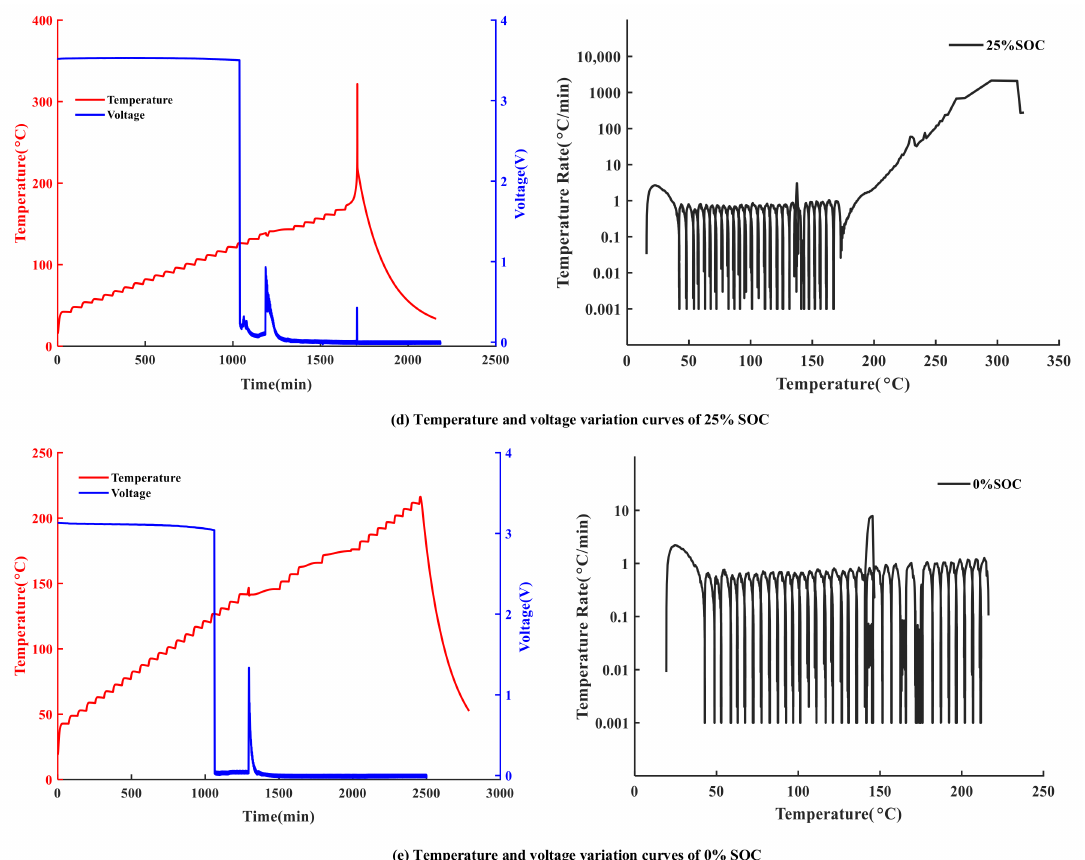
Figure 6. Temperature and voltage variation curves of different SOC